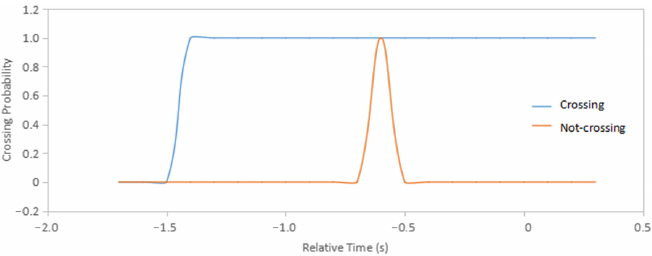
Figure 12. Pedestrian crossing intention prediction with relative time in different scenarios.